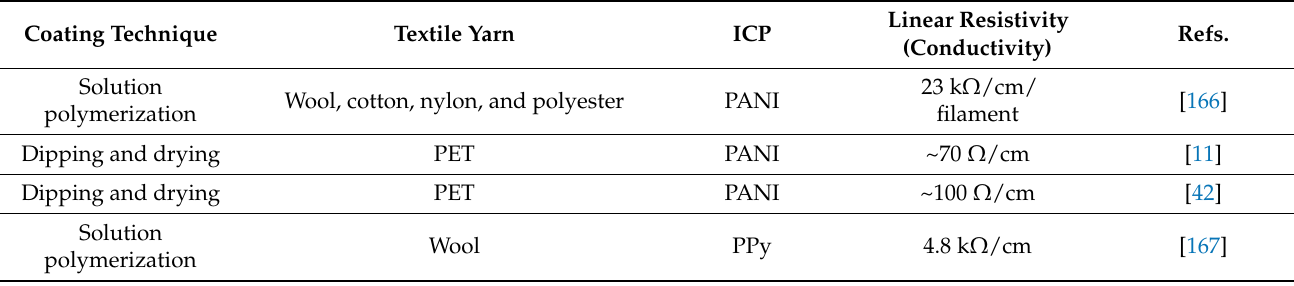
Figure 8. Active thermoregulation via electro-heat and thermoelectrics. ( a ) Photograph and IR image of a stretchable and energy-efficient smart Joule-heating textile. ( b ) Temperature and distribution profiles of the smart heating textile. ( c ) Smart textile with wearable thermoelectric devices (TEDs). ( d ) Skin temperature as a function of air temperature with a TED-based smart textile. ( e ) Skin temperature regulation via a TED-based smart textile under daily conditions. ( f ) IR image of a TED-based smart textile on and off the skin for temperature regulation. ( g ) Thermoelectric yarn and woven textiles for thermoregulation. ( h ) Output power of the plain-weave thermoelectric smart textile [156]. Table 7. Coating techniques of textile yarn with